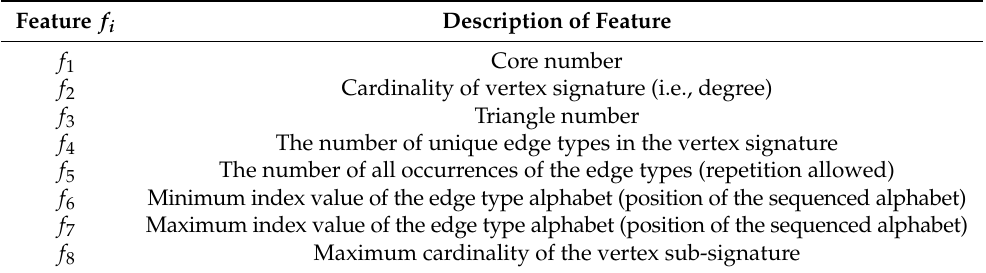
Table 2. Features that were used in our proposed